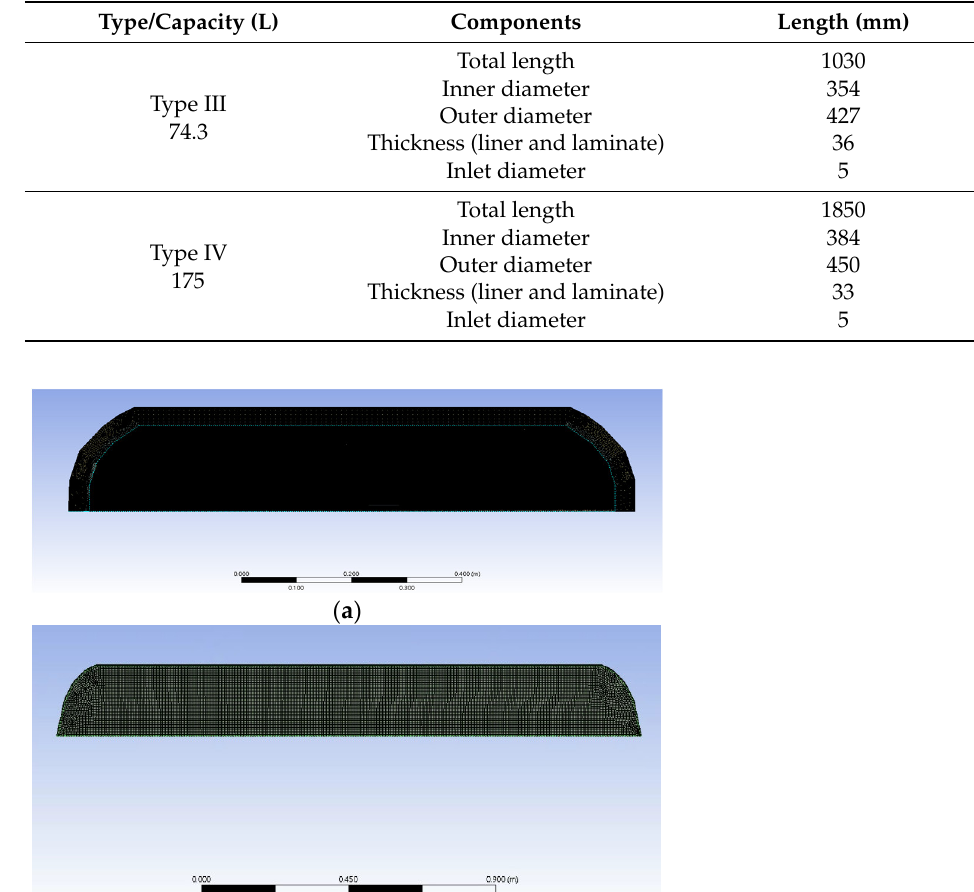
Table 1. Specifications of hydrogen tank.